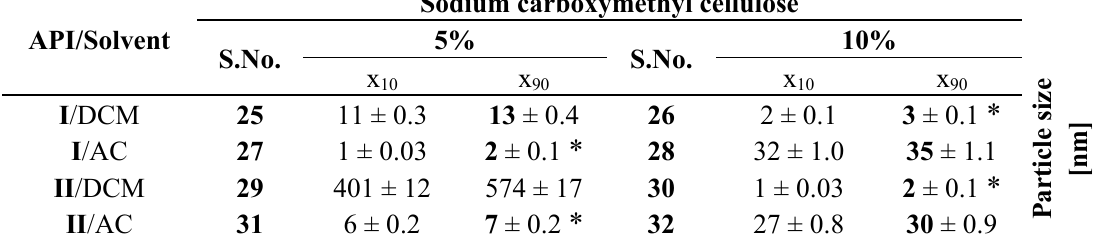
Table 4. Particle size (x , x [nm]) of APIs I , II and concentration [%] of sodium 10 90 carboxymethyl cellulose in dichloromethane (DCM) or acetone (AC). All the presented results are reported as the medium value of four independent measurements. The results of nano-size samples are expressed as the mean ± SD ( n = 4 measurements). The SDs of micro-size samples are not indicated due to the measurability range of Nanophox. Samples that contained nanoparticles <200 nm are bolded; nanoparticles <10 nm are indicated by asterisk. (S.No. = sample